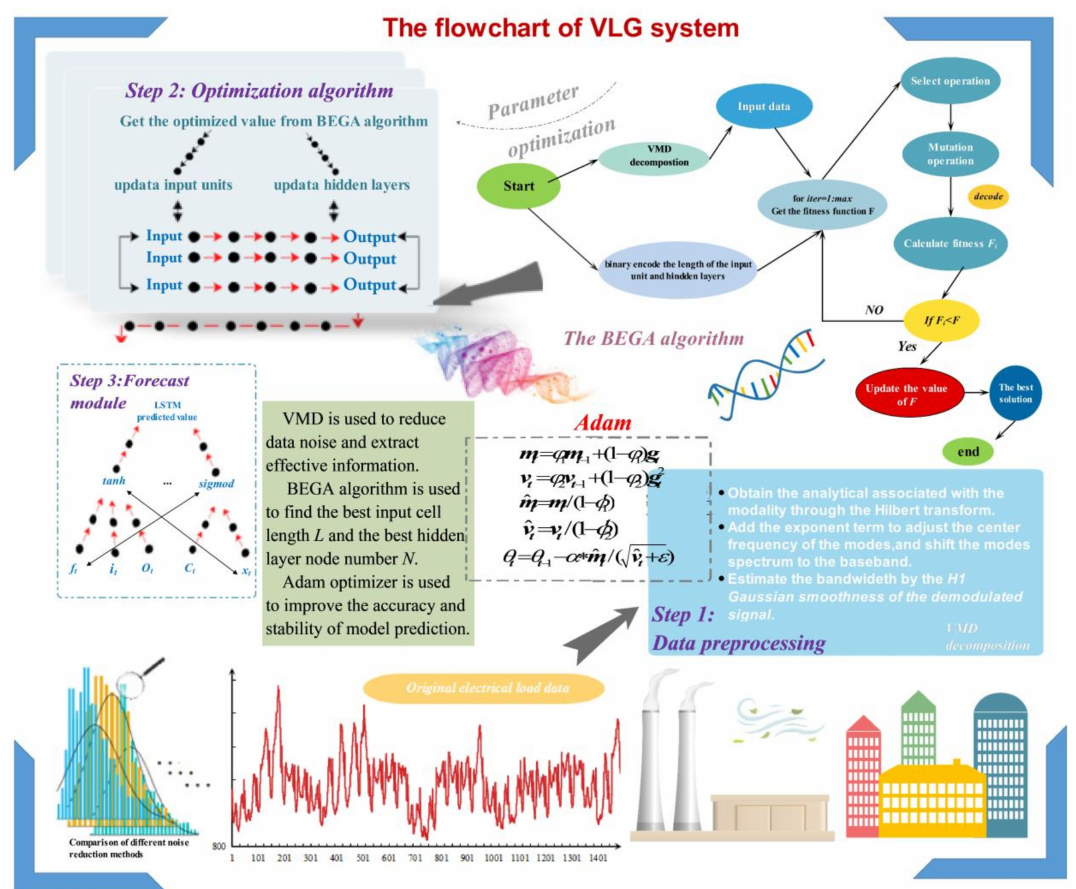
Figure 2. The flowchart of variational mode decomposition-binary encoding genetic optimization algorithm-LSTM (VLG)